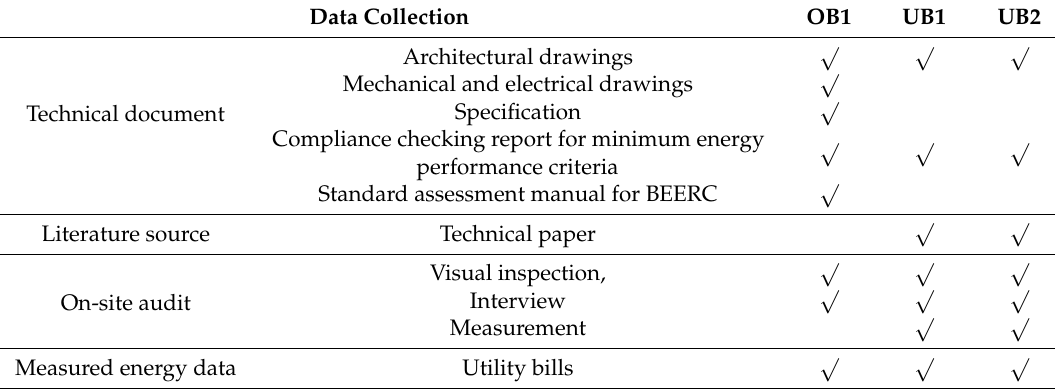
Table 6. Collected data by the buildings studied.